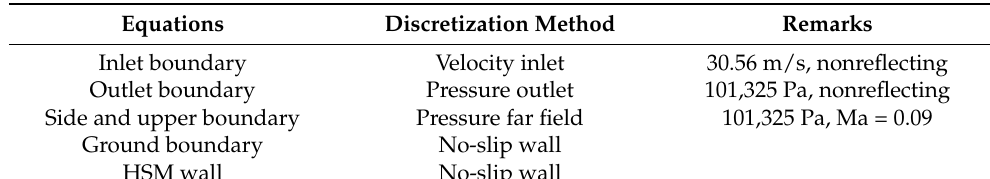
Figure 3. Target model of Hyundai Simplified Model (HSM) and entire computational domain: ( a ) overall shape of HSM with related geometric dimensions; ( b ) dimensions of computational domain with boundary conditions applied, where H denotes the height of the HSM. Table 2. Details on applied boundary conditions.